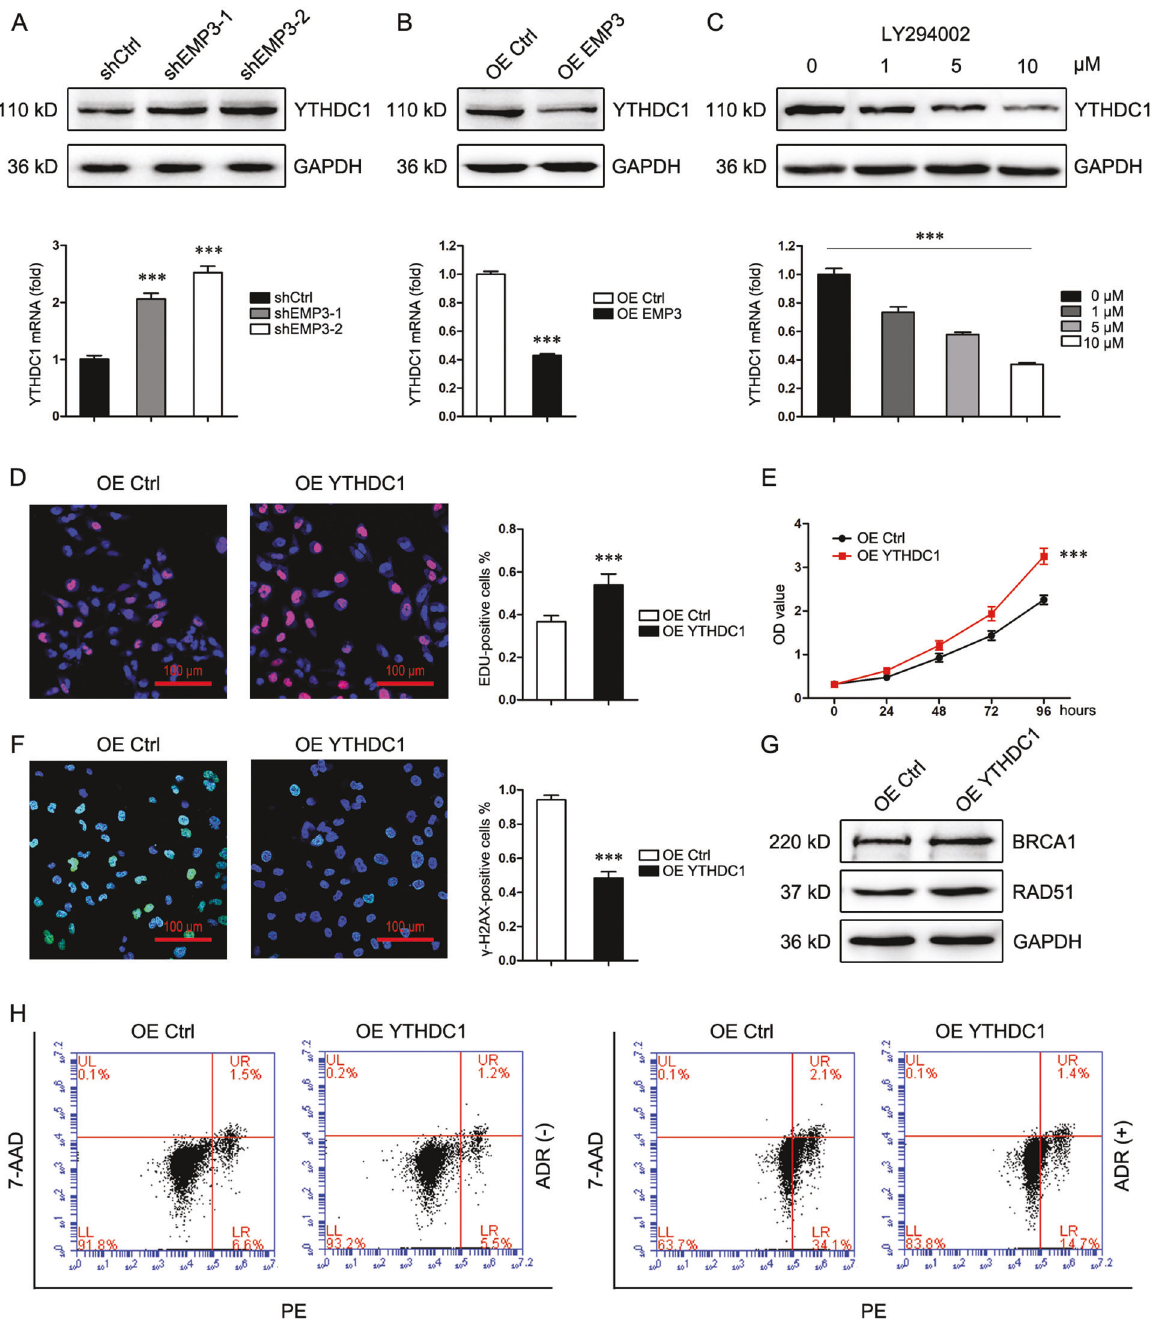
Fig. 6 YTHDC1 is a downstream effector of EMP3. A YTHDC1 expression in MDA-MB-231 cells was detected by western blot and real-time PCR. *** P <0.001, vs. shCtrl. B YTHDC1 expression in MCF7 cells was detected by western blot and real-time PCR. *** P < 0.001, vs. OE Ctrl. C YTHDC1 expression in MDA-MB-231 cells treated with LY294002 was detected by western blot and real-time PCR. *** P < 0.001. D DNA replication of MDA-MB-231 cells was analyzed by EDU staining. Mean ±SD, n = 3. *** P < 0.001, vs. OE Ctrl. E Viability of MDA-MB-231 cells was analyzed by CCK8. Mean ±SD, n = 3. *** P <0.001, vs. OE Ctrl. F γ -H2AX expression in MDA-MB-231 cells was detected by Immuno fl uorescence staining 48 h after treatment with ADR (500nM). Mean ±SD, n = 3. *** P <0.001, vs OE Ctrl. G BRCA1 and RAD51 expression in MDA-MB-231 cells were detected by western blot. H Death of MDA-MB-231 cells was detected by fl ow cytometry 48h after treatment with or without ADR (500 modi fi cation and m6a reader YTHDC1 promote homologous recombination repair by modulating BRCA1 and RAD51 [24]. The negative modulation of YTHDC1 by EMP3 and the effect of YTHDC1 overexpression on breast cancer cells together demon- strate that YTHDC1 and m6A modi fi cation at least in part between EMP3 and YTHDC1 hints at the involvement of m6A mediate EMP3-induced suppression of homologous recombina- modi fi cation in EMP3-mediated DNA damage repair (Fig. 7). tion repair.